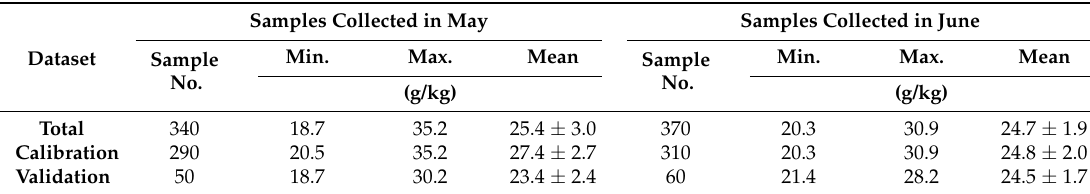
Table 1. Chemically measured nitrogen concentration in pear leaves (2014) used for modelling calibration and